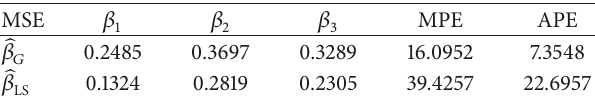
Table 2: Simulation results of estimation and prediction for Exper- iment 2 with 𝑚 = 10 and 𝑛 = 10 .